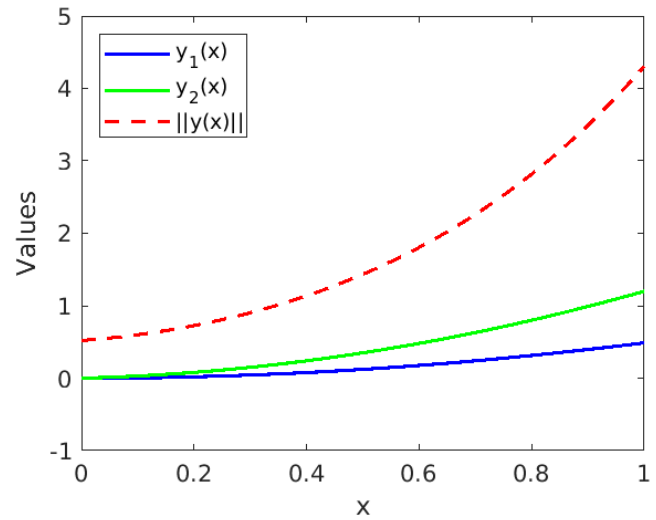
Figure 1. The state y ( x ) and || y ( x ) || of (21). Table 1. Finite-time stability results of (21) and fixed the time L = 1.